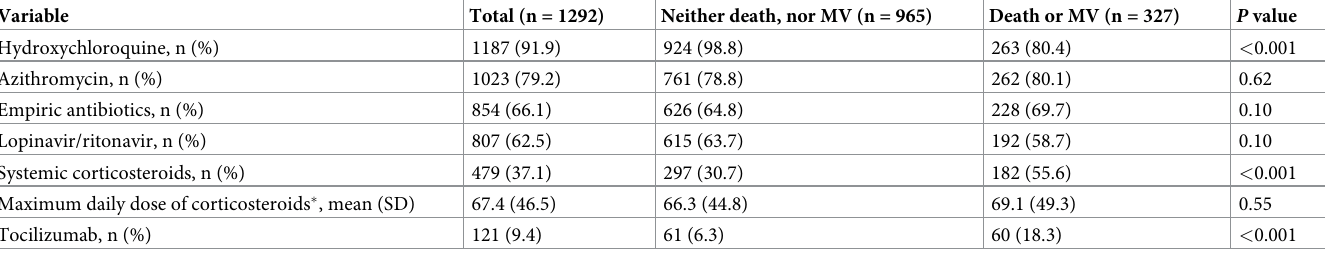
Table 3. Medications administered during hospitalization and prior to mechanical ventilation (MV).